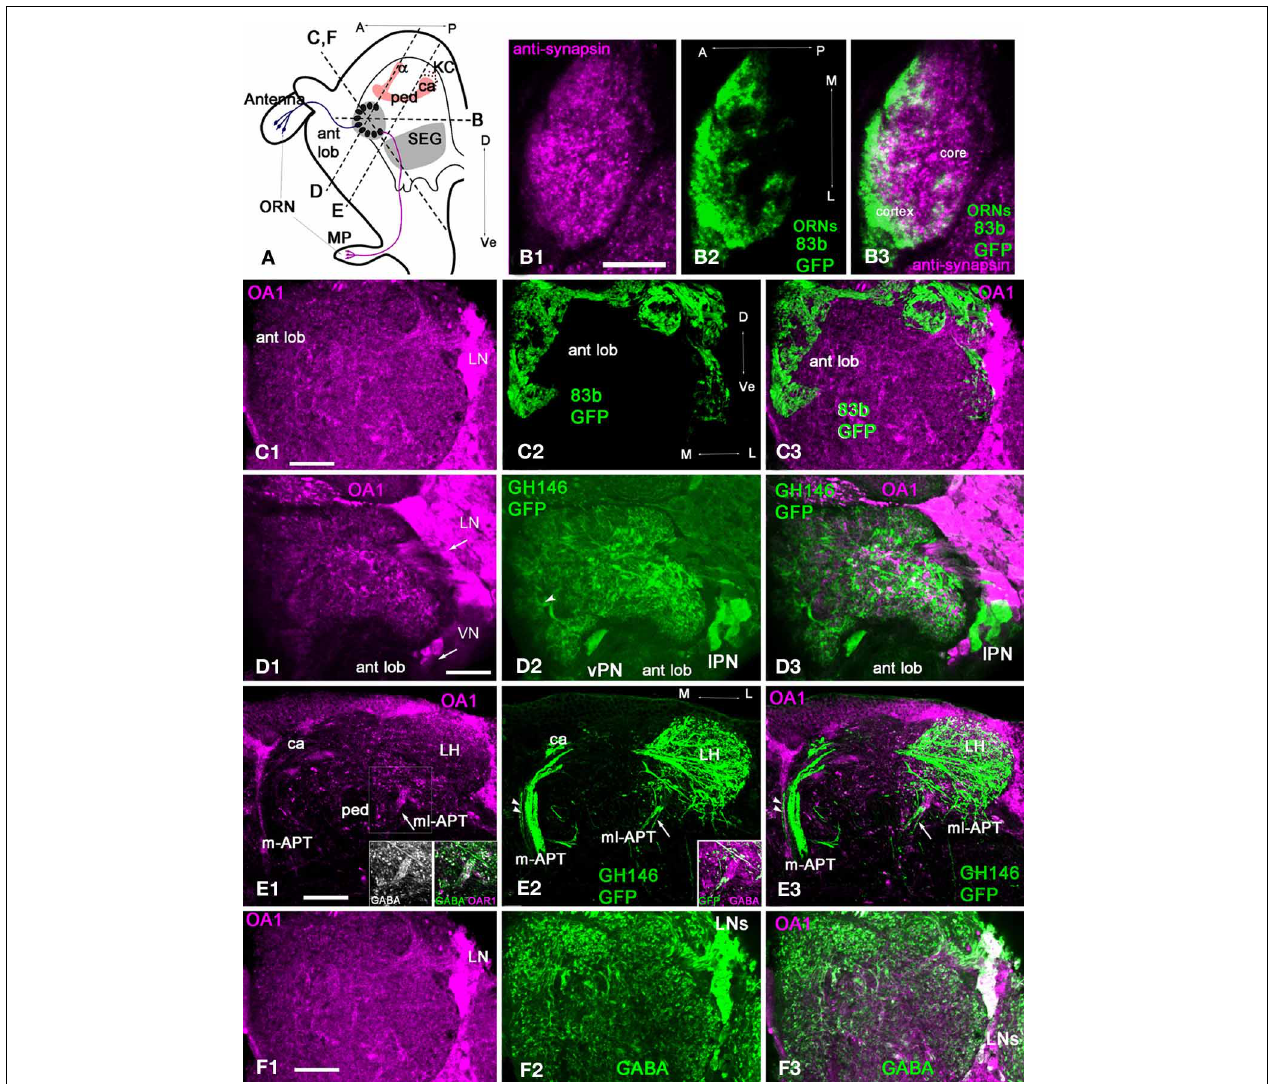
FIGURE 6 | Drosophila melanogaster : a subpopulation of GABAergic neurons are co-stained with anti-OA1 antibodies. (A) Schematic of the organization of the Drosophila olfactory system in sagittal view. MP, maxillary palp; ORN, olfactory receptor neuron; SEG, subesophageal ganglion; ant lob, antennal lobe; ca, calyx, ped, pedunculus; v, vertical lobe of MB; A, anterior; P, posterior; Dorsal, Ve- ventral. Broken lines indicate the approximate orientation of sections through antennal lobe (in C,F,D ) and lateral protocerbrum (E) . (B) Section through the center of one glomerulus labeled with anti-synapsin (green, B1 ) and anti-GFP in ORNs (magenta, B2 ) in OR83b-GAL4;UAS-mcd8-GFP flies. The glomerulus has a core area where the ORNs do not branch (B3) . (C1) Anti-OA1 stained groups of cells and processes in the glomeruli and the aglomerular neuropile area of the antennal lobe in OR83b-GAL4;UAS-mcd8-GFP ( C1 , magenta) on the oblique frontal brain cross-section of the antennal lobe. (C2) In the same section, GFP (green) takes up a large percentage, or perhaps all, of the olfactory receptor endings in the antennal lobe glomeruli. (C3) The majority of the sensory neurons terminals do not label with the OA1 antiserum (magenta) with a few exceptions. (D,E) Anti-OA1 antibodies do not label the majority of uniglomerular projection neurons (uPNs). (D1) Here, anti-OA1 labeled clusters of cells surrounding the antennal lobes. These neurons are not projection neurons. GH146-GAL4; UAS-mcd8-GFP projection neurons expressed GFP (green) (D2) . In GFP expressing neurons there is no OA1 immunoreactivity as